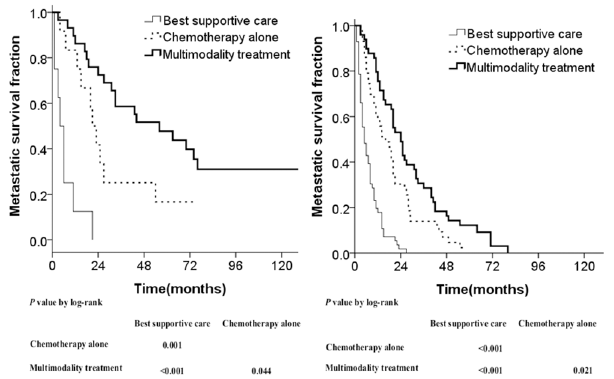
Fig 3. Metastatic survival curves stratified by treatment modalities in different number of metastases: oligometastasis (A) and multimetastasis (B).